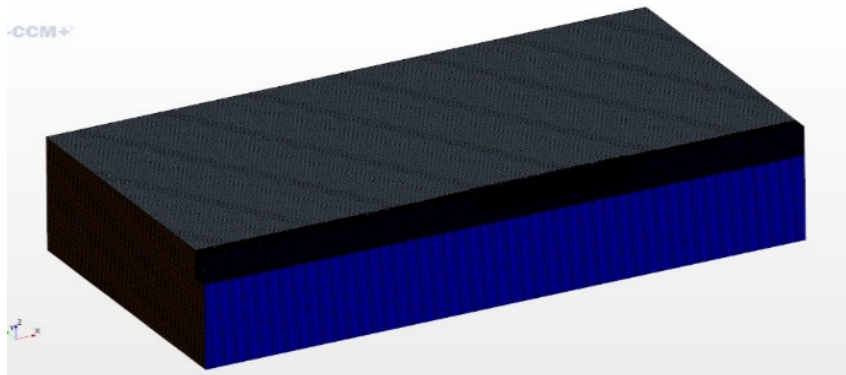
Figure 2. Volume grid of whole area.